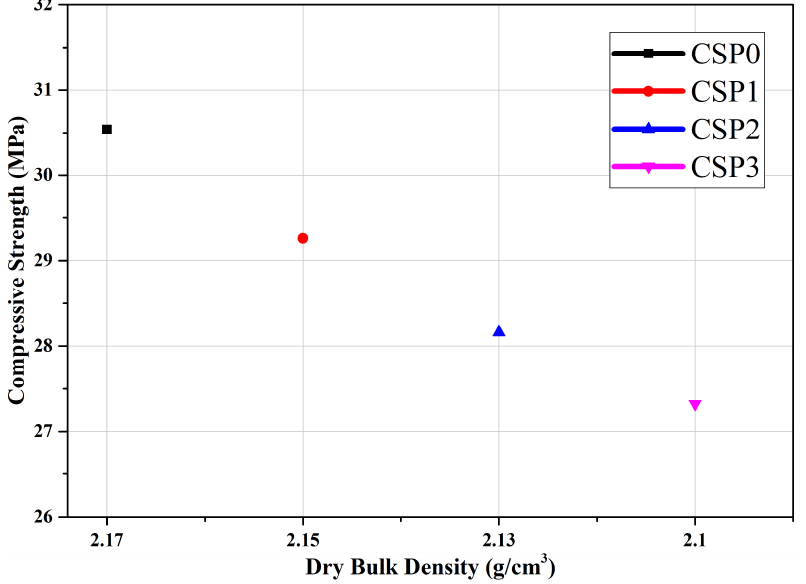
Figure 17. Relationship between compressive strength and dry bulk density of the control samples.